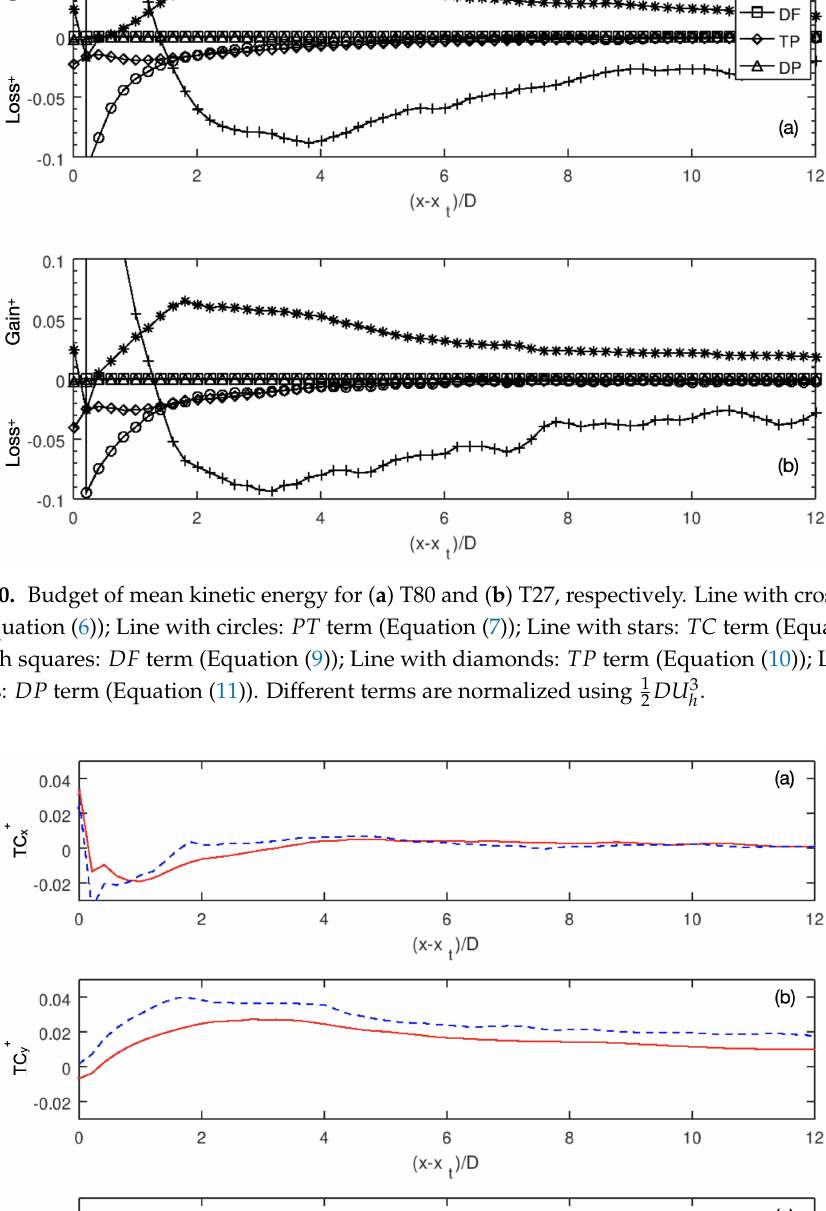
Figure 11. The three components of the turbulence convection (TC) term for ( a ) TC x (Equation (13)), ( b ) TC y (Equation (14)) and ( c ) TC z (Equation (15)), respectively. Red line: T80; Blue line: T27. DU 3 Different terms are normalized using 1 2 h